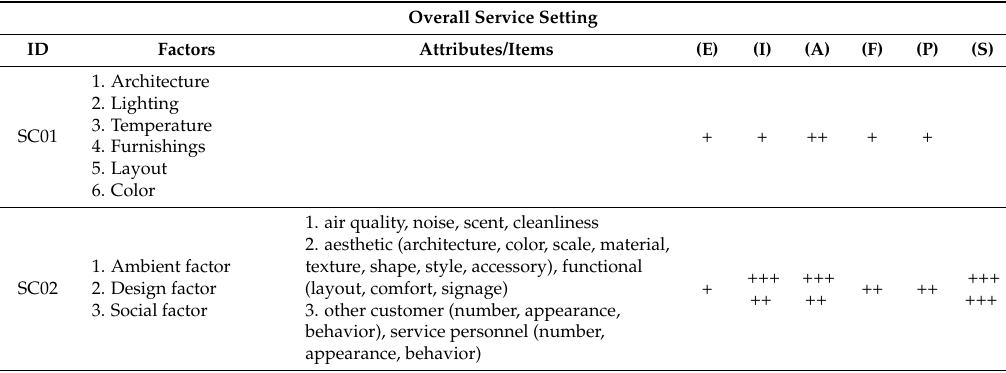
Table 5. Factor classification by the servicescape